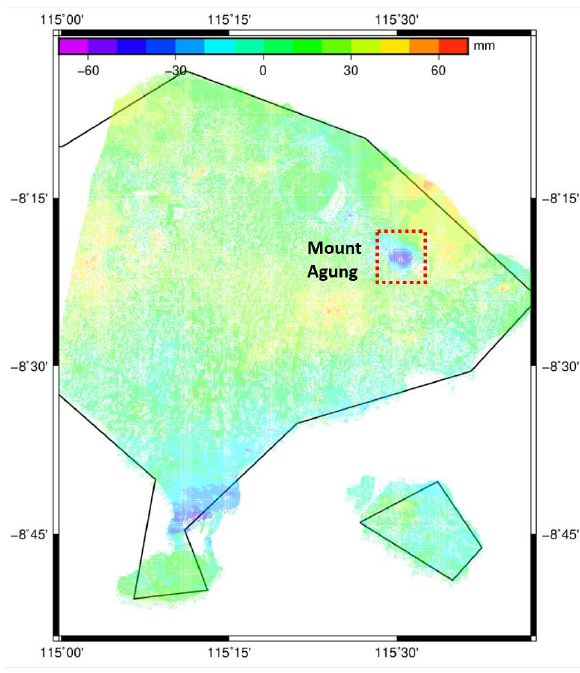
Figure 14. Line of Sight (LoS) displacements Unwrapped interferograms show total displacement of deformation in the satellite's LoS. An unwrapped interferogram was created by adding the fringes together from the wrapped interferogram. Based on LoS calculation, as shown in Figure 14, the unwrapped pattern at the mountain area reaches a maximal LoS deformation. The vertical displacement with maximum value is close to 6 cm, agreeing with the findings of the wrapped interferogram. It means that the ground movement has moved away from the satellite indicating the distance between the ground and the satellite has